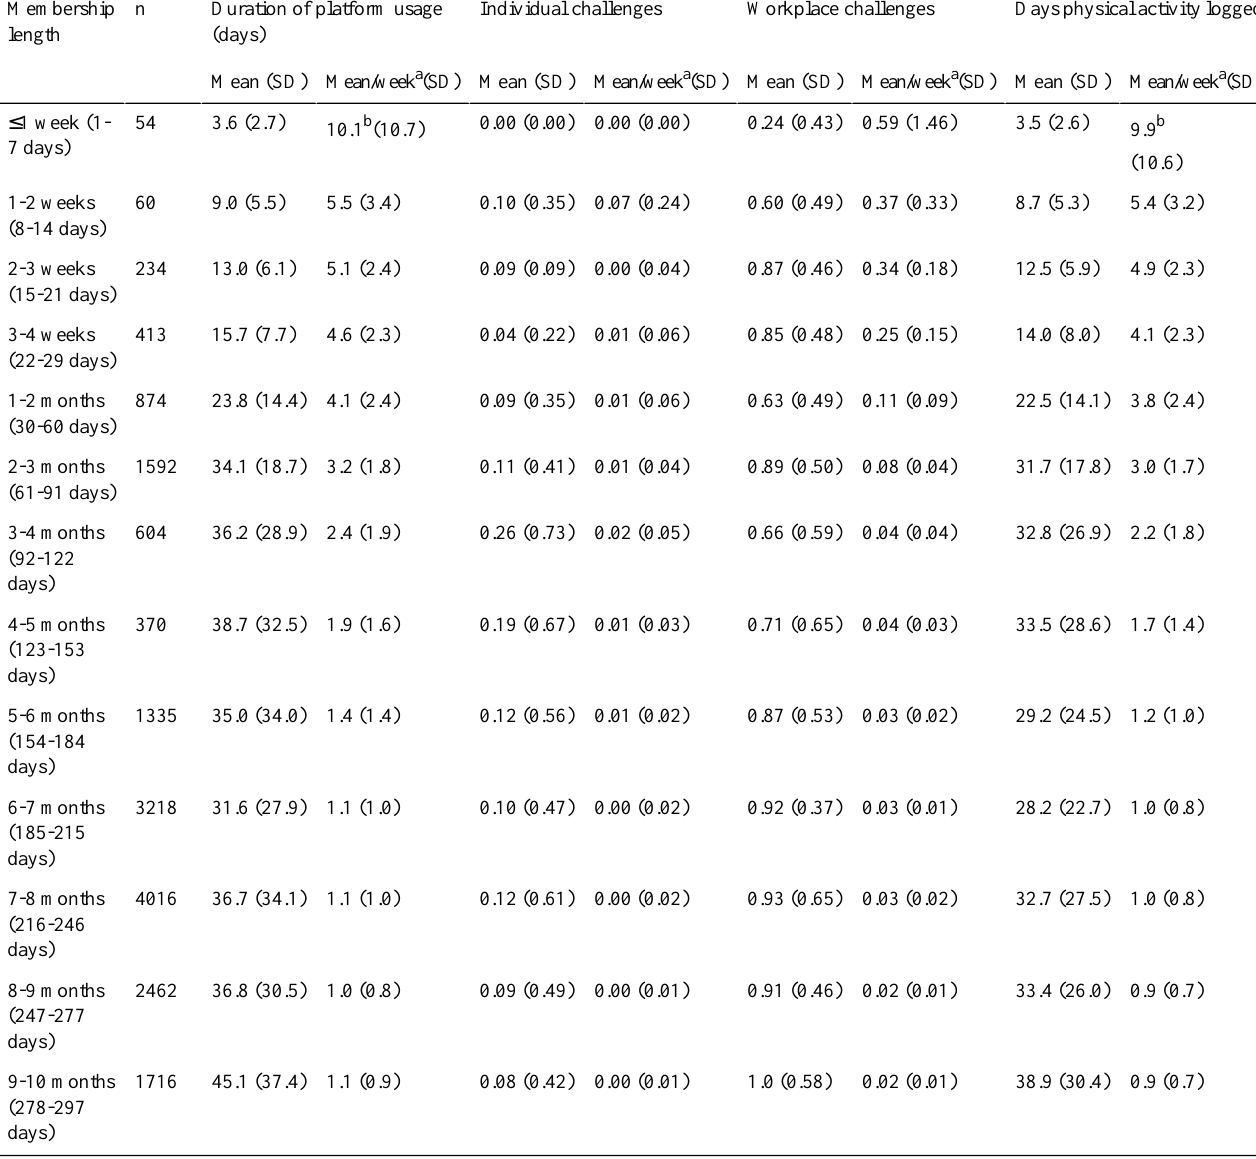
Table 2. Mean engagement parameters for different membership lengths in the overall sample (N=16,948). length